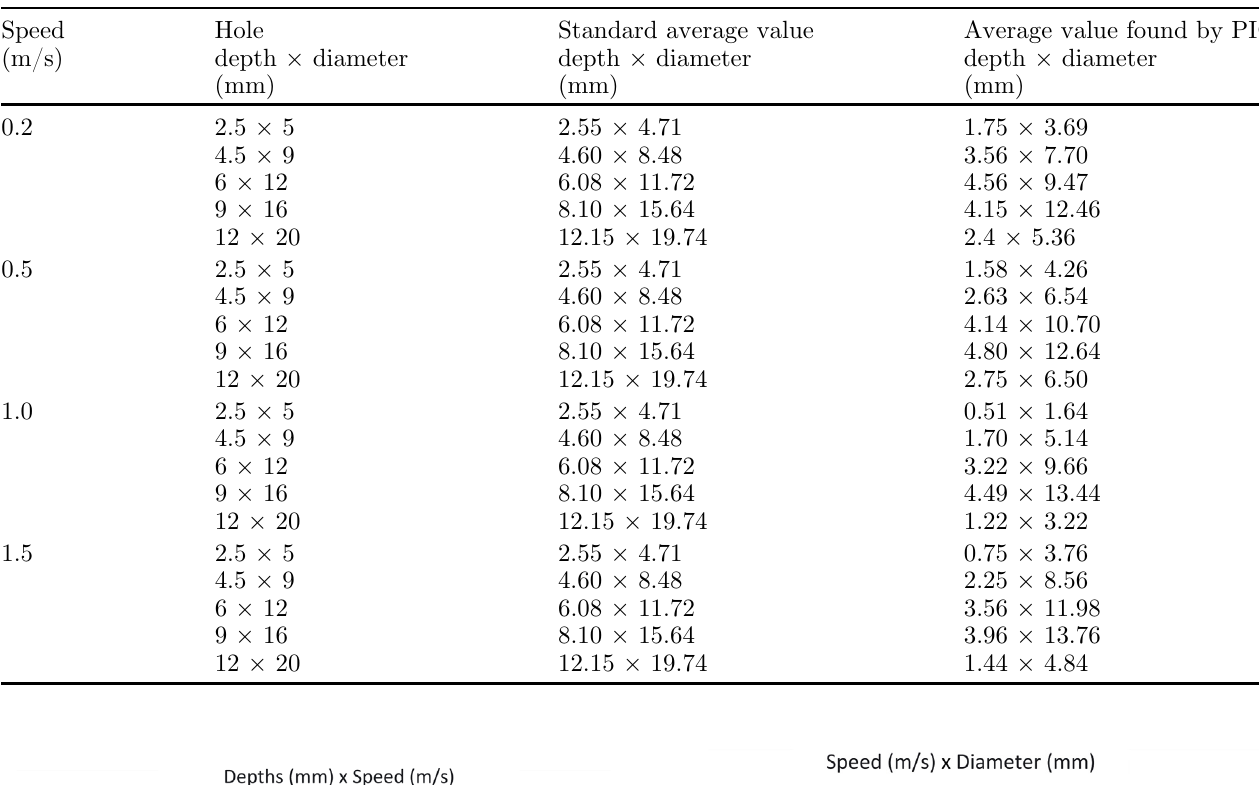
H. Figueiredo Junior et al.: Int. J. Metrol. Qual. Eng. 13 , 15 Table 2. Values found in the test.